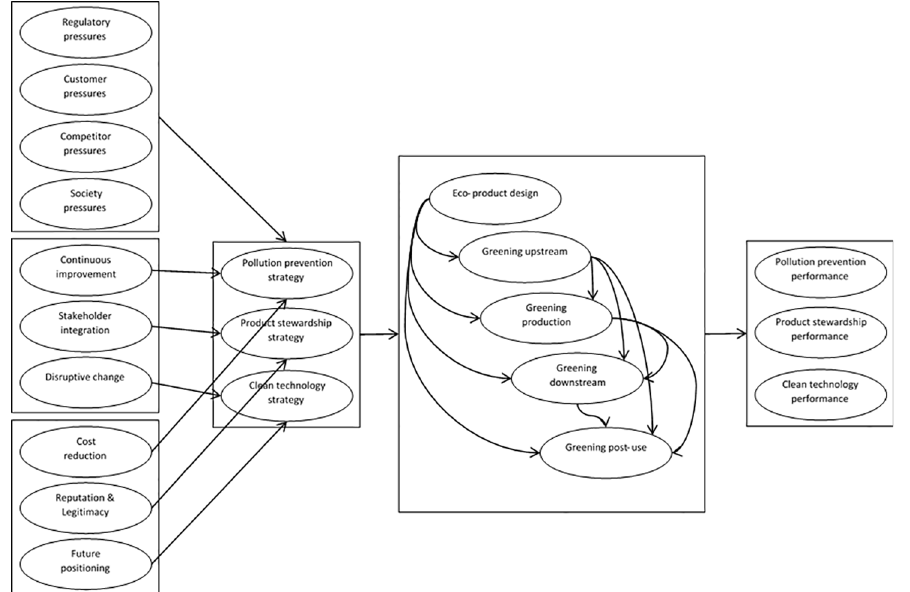
Fig 2. Causal relationship between the decision